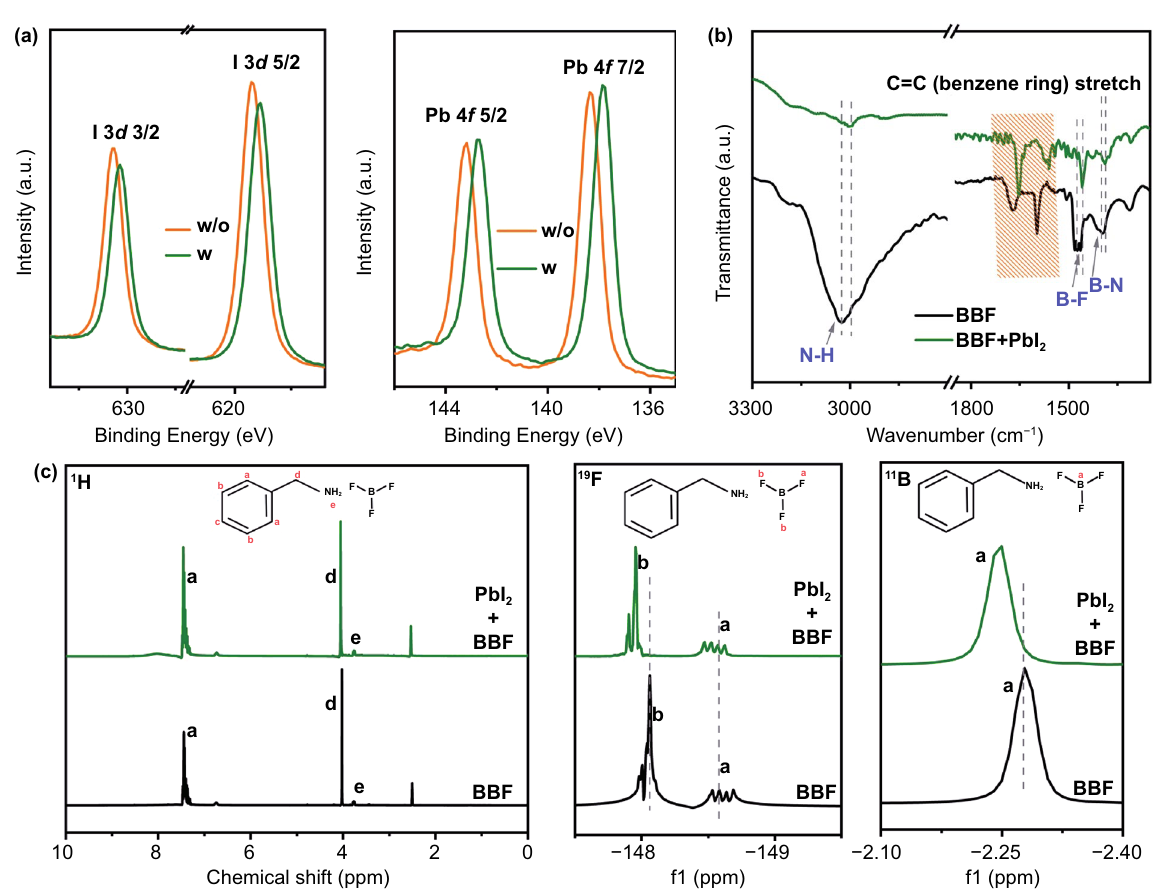
Fig. 3 a I 3d and Pb 4f XPS spectra of the perovskite film with and without BBF additive. b FTIR spectra of BBF solution with and without PbI 2 . c 1 H, 19 F, 11 B NMR of BBF solution with and without PbI